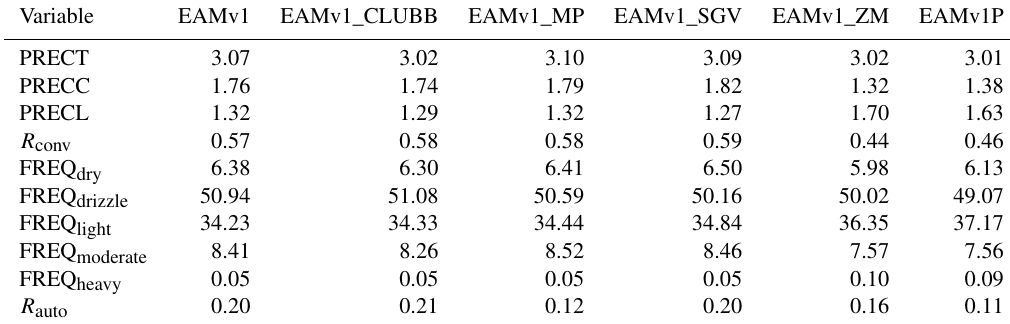
heavy precipitation with precipitation rates exceeding 80mmd − 1 (FREQ heavy ); and ratio of autoconversion to total precipitation ( R auto